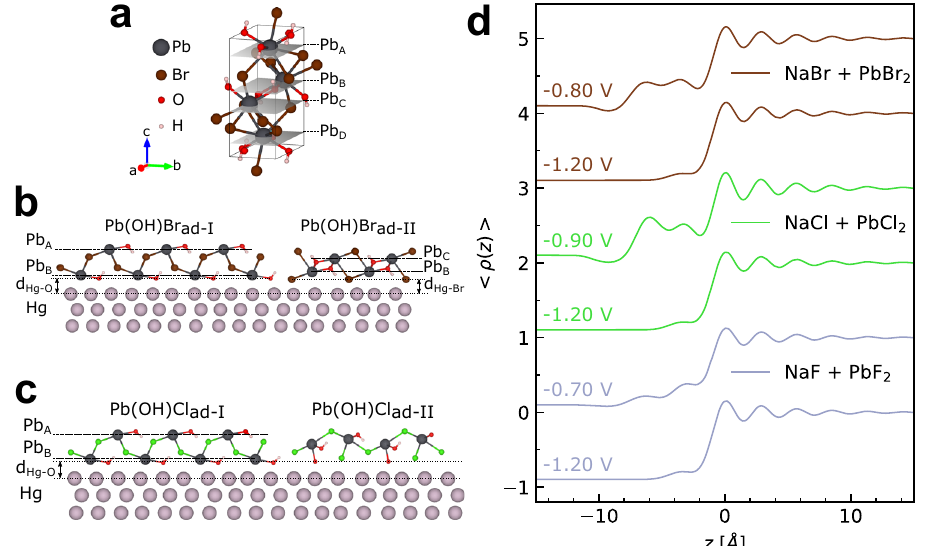
Fig.5|BulkandinterfacestructureofthePbBr 2 andPbCl 2 systems.a Laurionite Pb de-amalgamation in Br (brown), Cl (green), and F (blue) containing electrolyte. c , d StructuralmodelsusedtodescribetheHg-electrolyteinterfaceinthepresence crystal structure, illustrated for the case of Pb(OH)Br (generated by VESTA 72 ). (cid:3) (cid:4) b Pro fi les of the electron density ρ z ð Þ obtained from fi ts of the XRR measure- of Pb-containing adlayers for the case of c Br and d Cl ments in Fig. 2, corresponding to the interface structurein the potential regime of